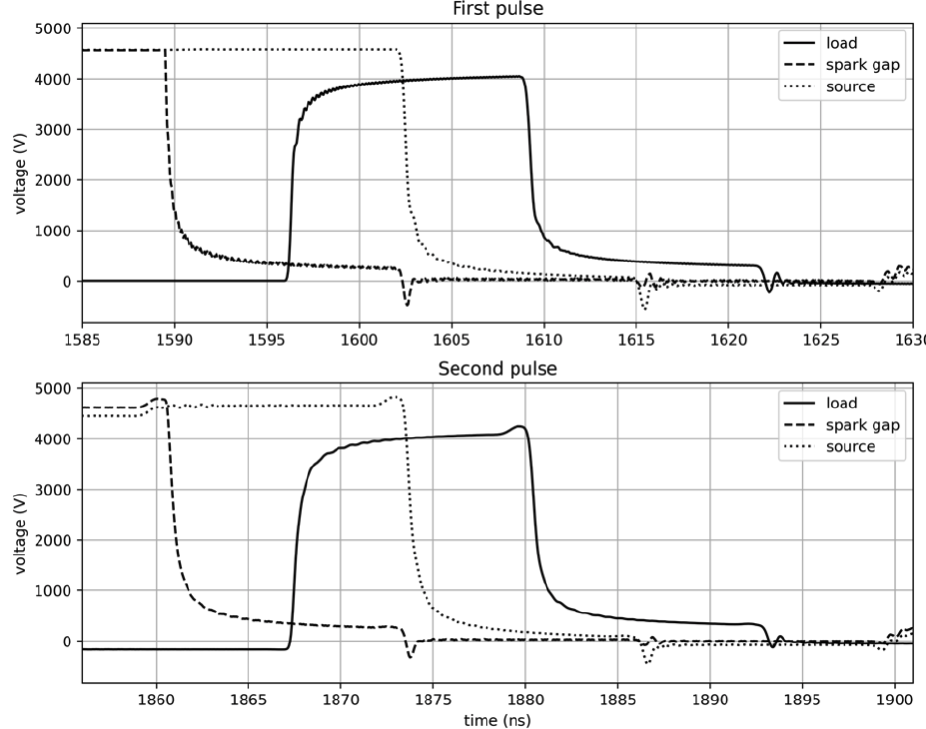
Figure 5. Voltages across the matched load, the spark-gap (realistic model) and the high voltage DC power